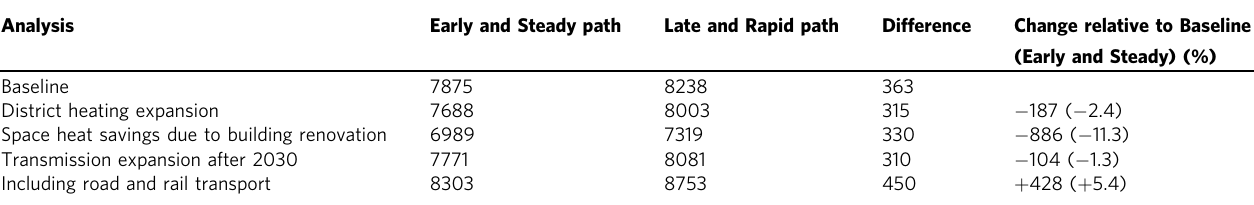
Table 1 Cumulative system costs (B € ) for additional